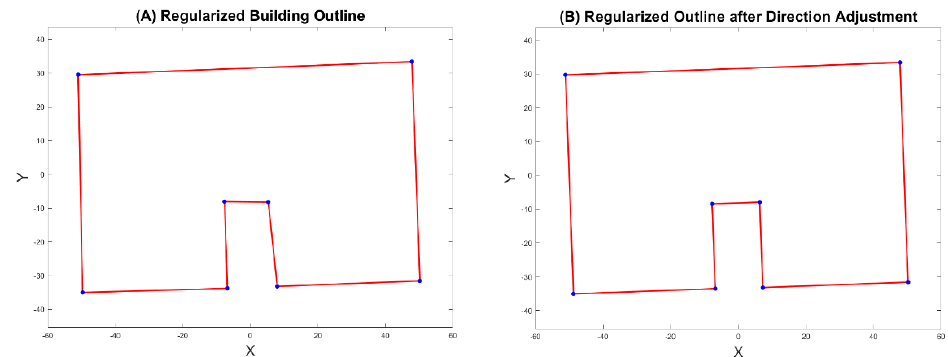
Figure 12. ( A ) Regularized building outline without the zig-zag shape. ( B ) Regularized building footprint with adjusted direction.